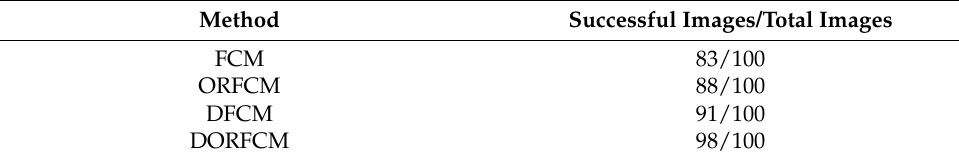
Table 1. Extraction rate of inflamed